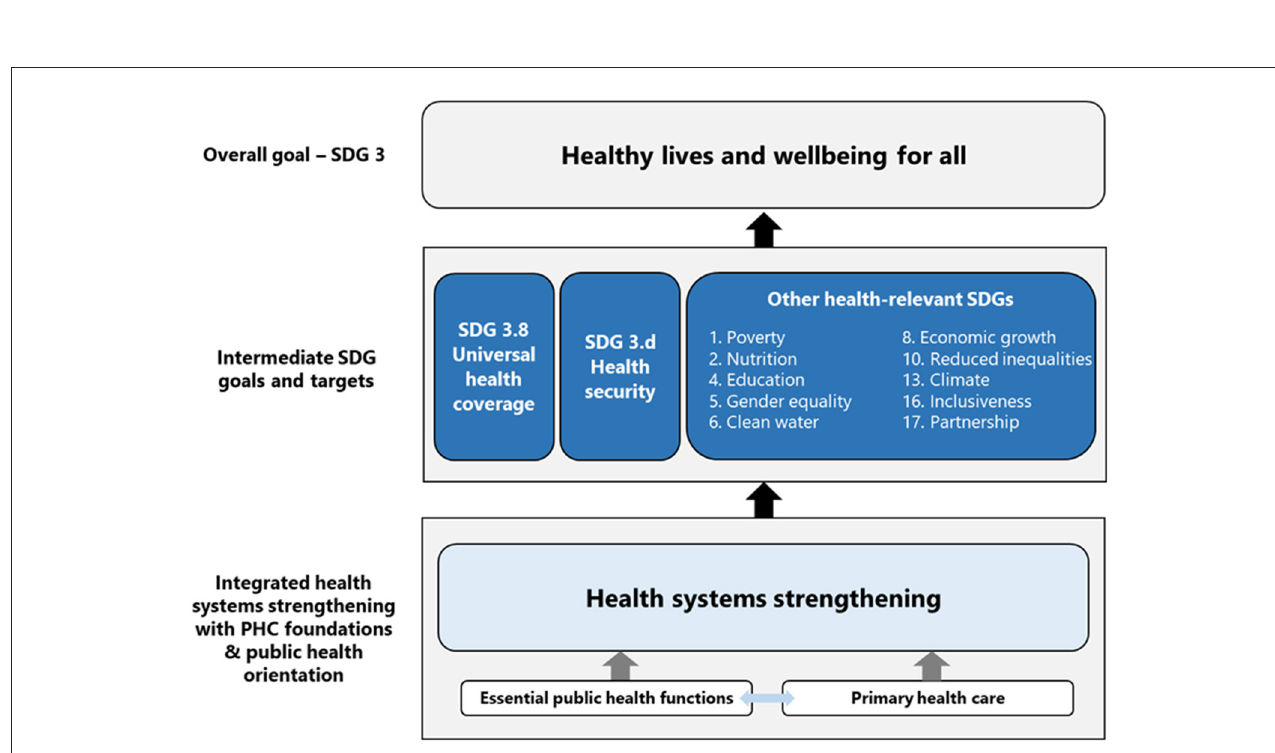
FIGURE2 Illustration how health systems strengthening with primary health care foundations and public health orientation contributes to SDG 3 through supporting UHC, health security and other health-related SDG targets [adapted from (77,